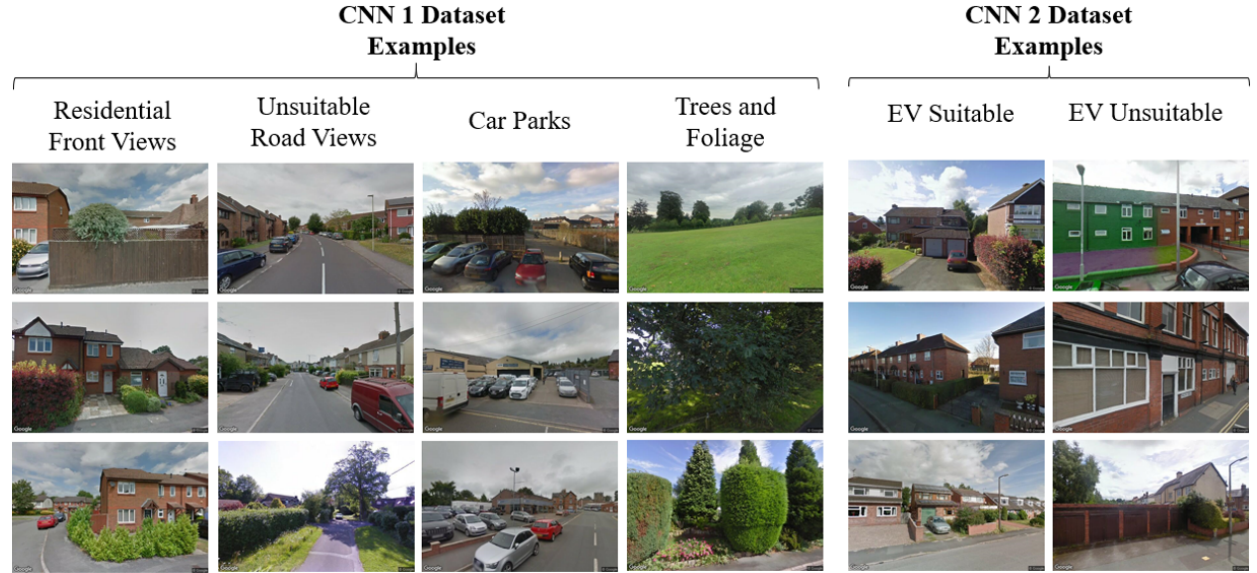
Figure 2. Example images from each of the categories in the two datasets.